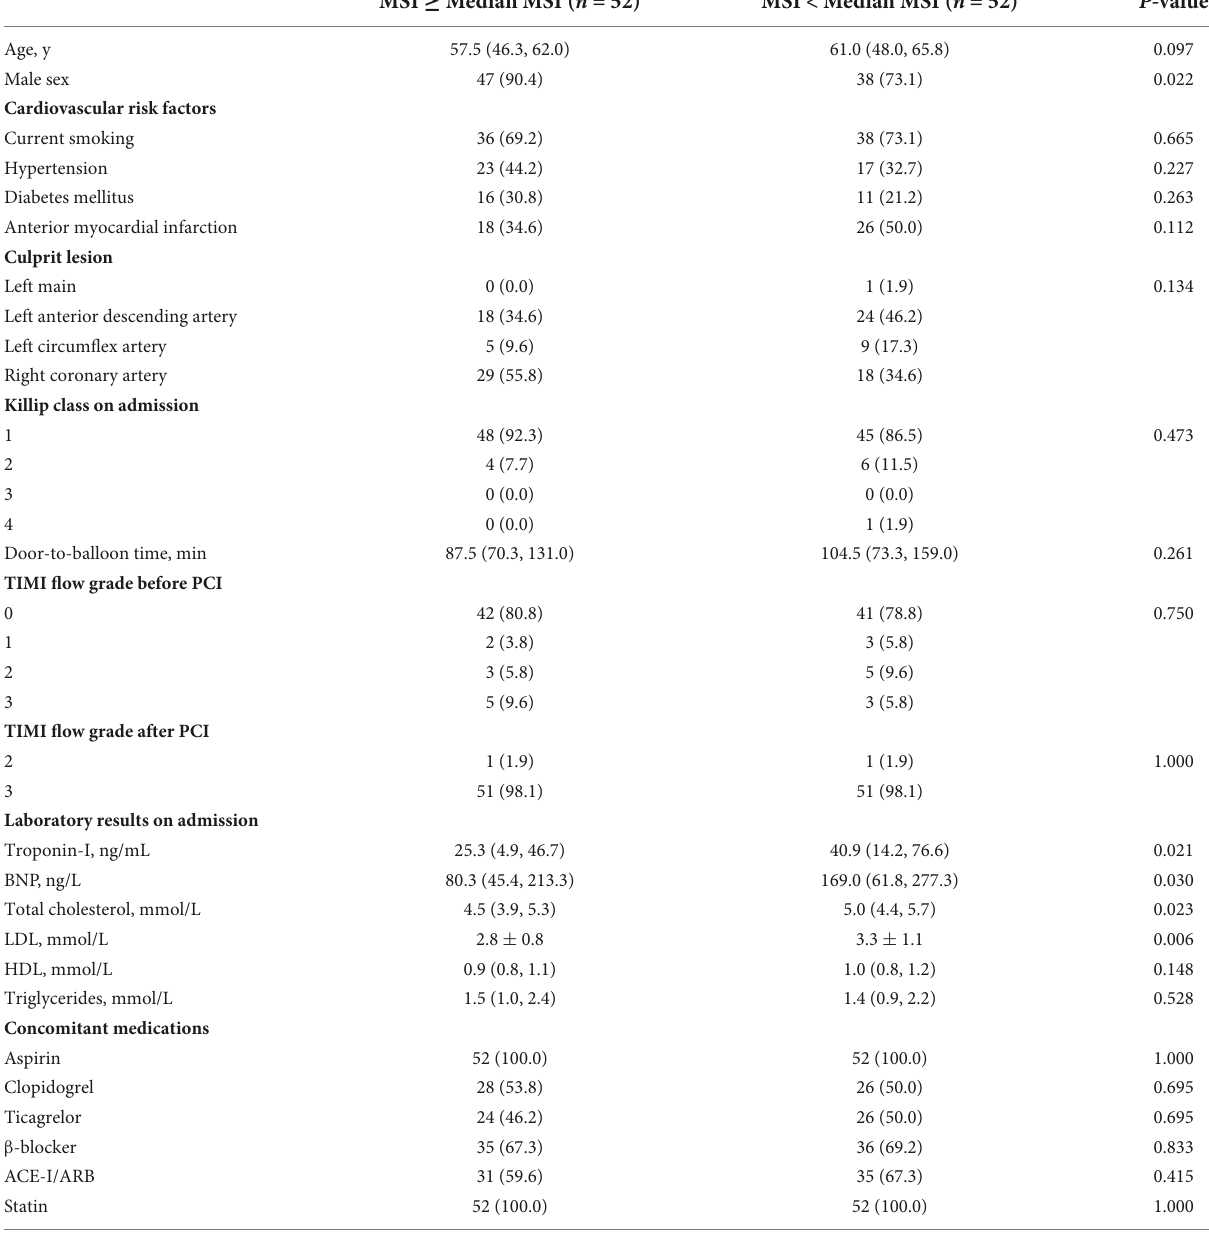
TABLE 1 Main patient